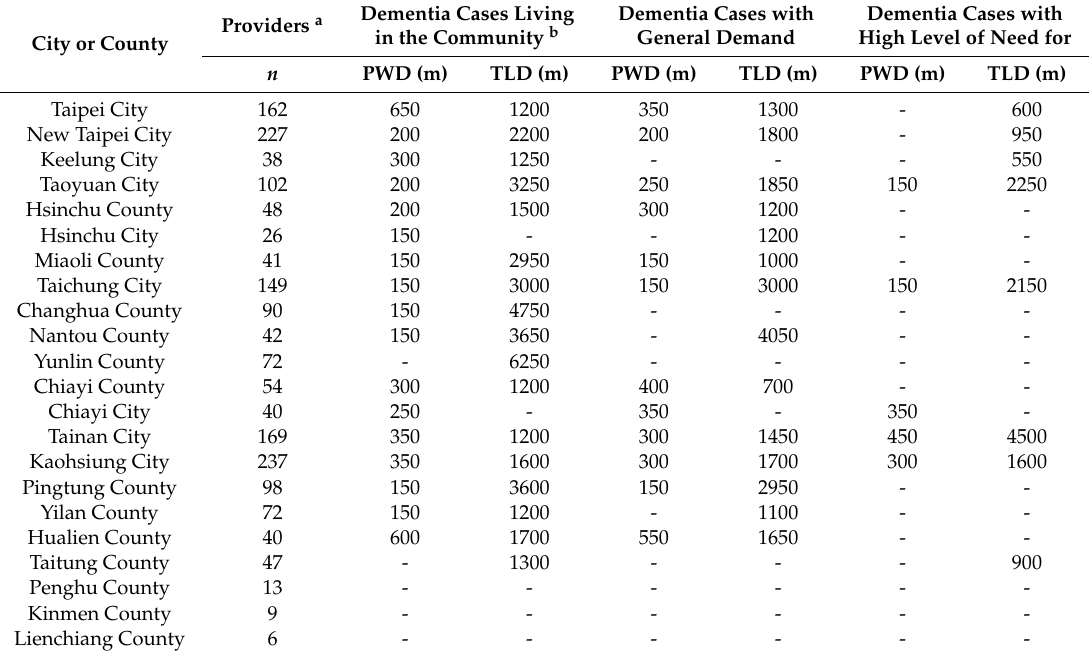
Table 4. The profit willing distances (PWDs) and tolerance limited distances (TLDs) of 22 administrative areas in